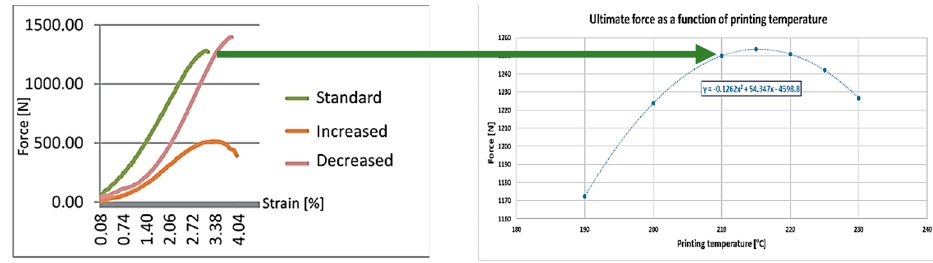
Figure 14. The tensile strength dependence on the printing temperature.